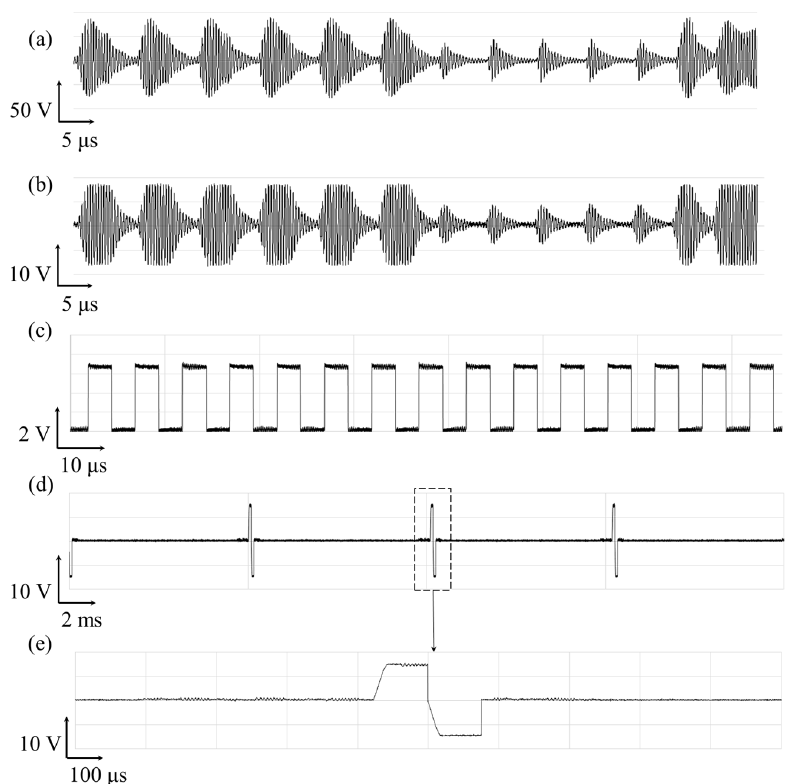
Figure 4. Exemplar waveform of the wireless operation of spinal cord stimulator and its stimulation current pulse generation. The voltage measured across the ( a ) the transmitter coil and ( b ) the receiver coil; the output voltage at the ( c ) oscillator; and ( d , e ) stimulation generator ASIC.